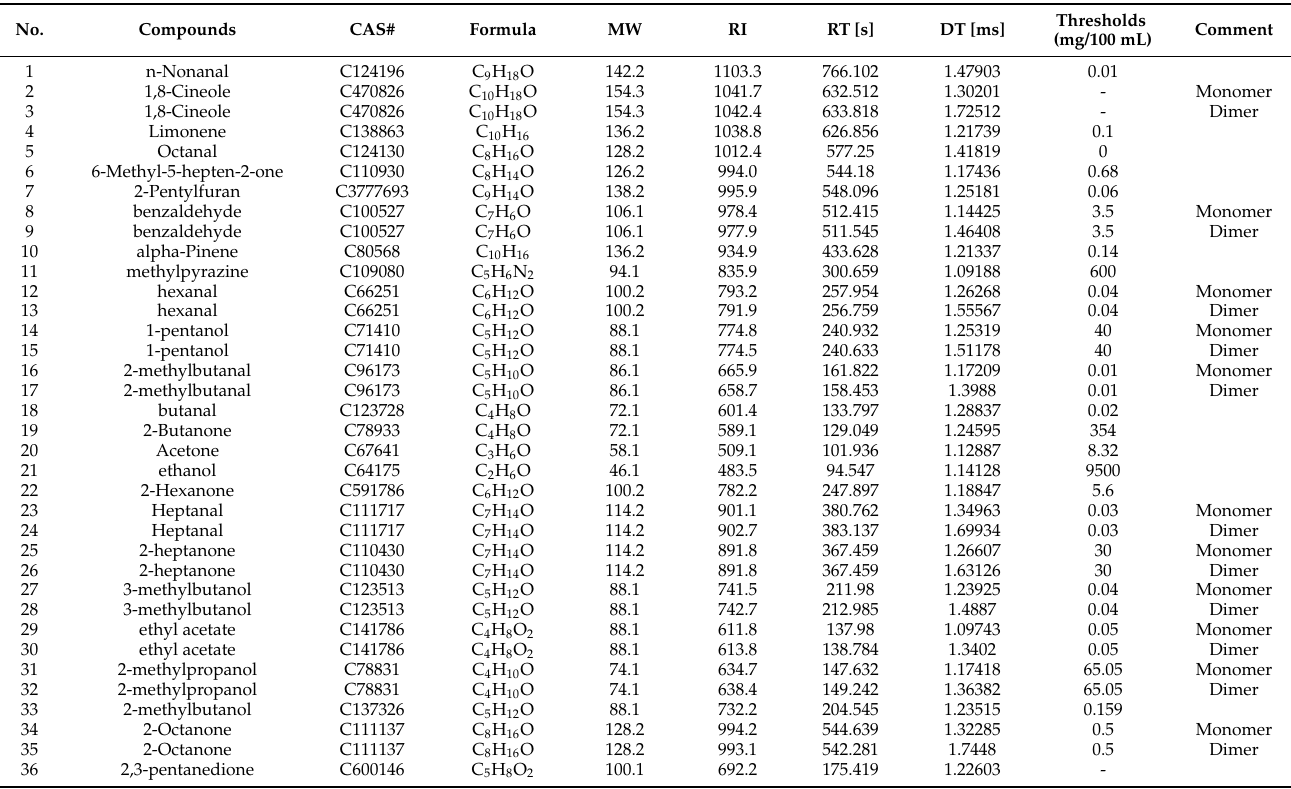
Table 2. Volatile compounds detected from tilapia fish cakes via